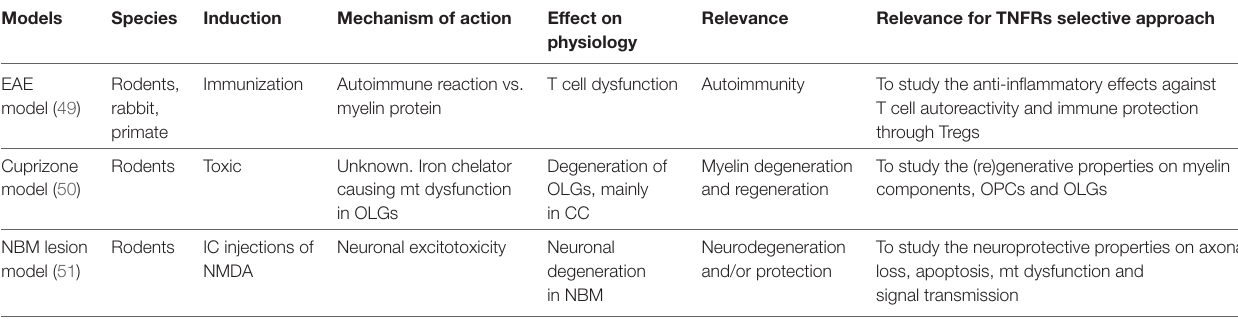
TAbLe 1 | Animal models to investigate pharmacological interventions for multiple sclerosis (MS).